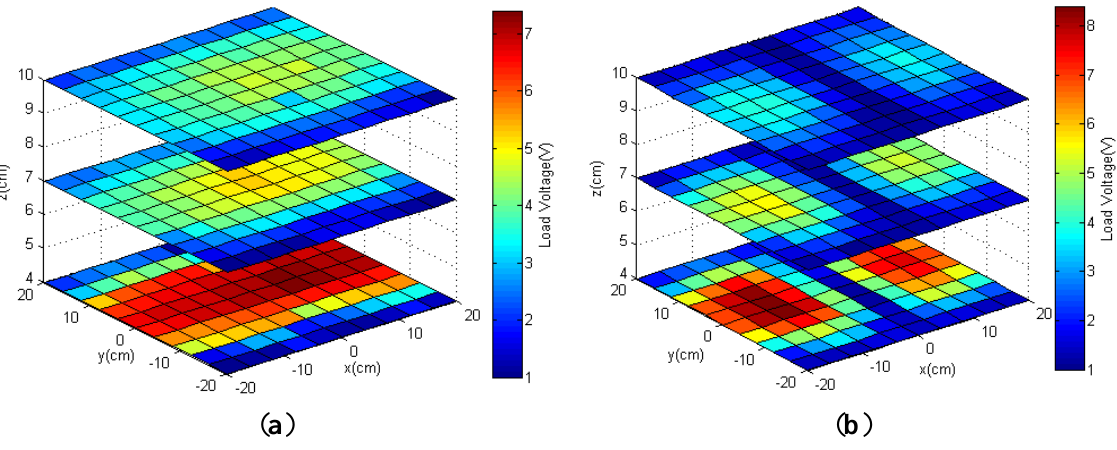
Figure 11. Measured load voltages at different planes at z = 4, 7 and 10 cm when using two TX antennas were ( a ) in-phase and ( b )